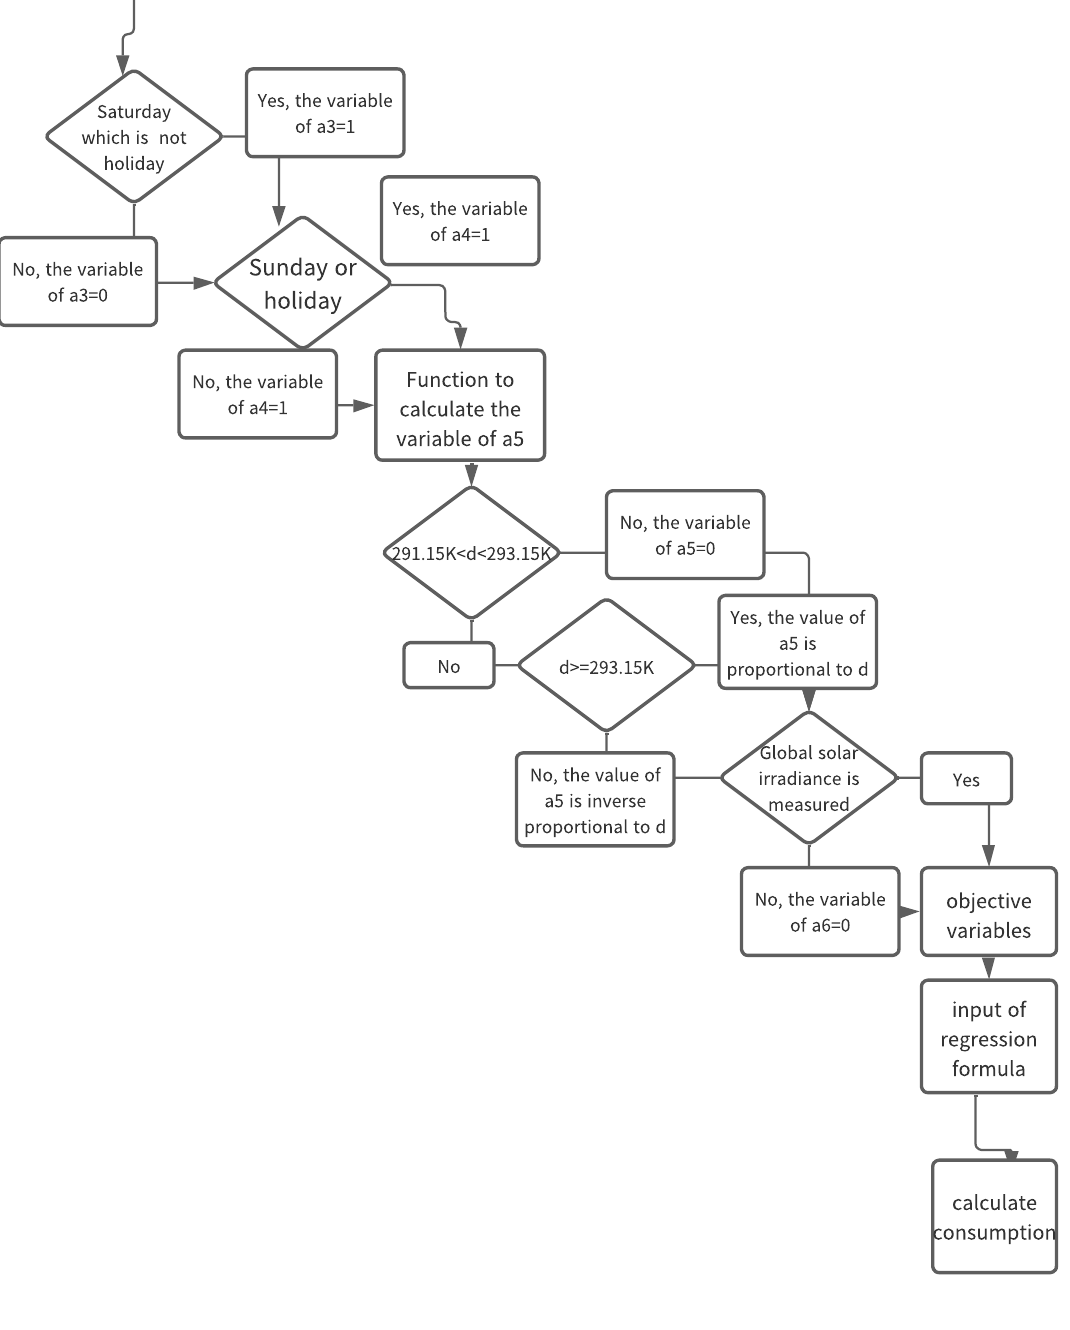
Figure A1. Flowchart for calculating cunsumption